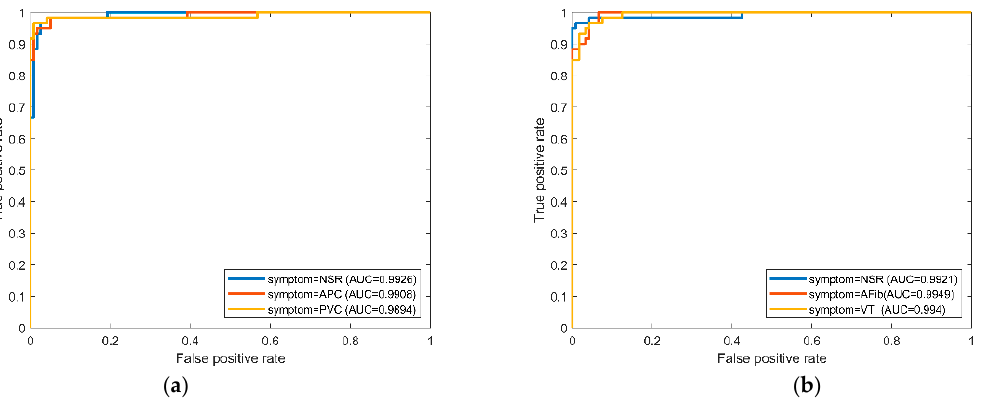
Figure 5. The one-versus-rest ROC curves in the RF model for the NSR versus the premature and fibril-rapid pattern due to the best performance fold in cross-validation by training data set A: ( a ) NSR versus premature pattern (i.e., APC–VPC); ( b ) NSR versus fibril-rapid pattern (AFib–VT).